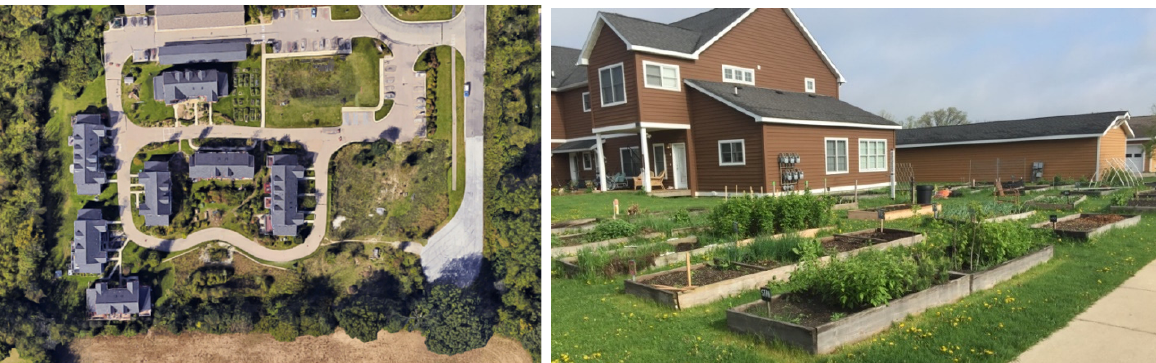
Figure 1. An aerial view of Touchstone, and garden plots. Some plots are private, others shared. When visited in 2016, Touchstone was in the middle of building its own common house. The community’s construction process was interrupted by the economic crisis in